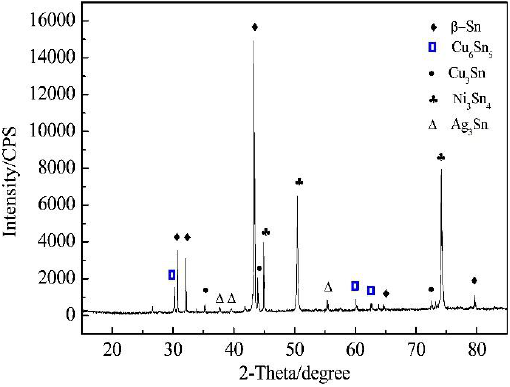
Figure 7. XRD analysis of fracture after 300 cycles.